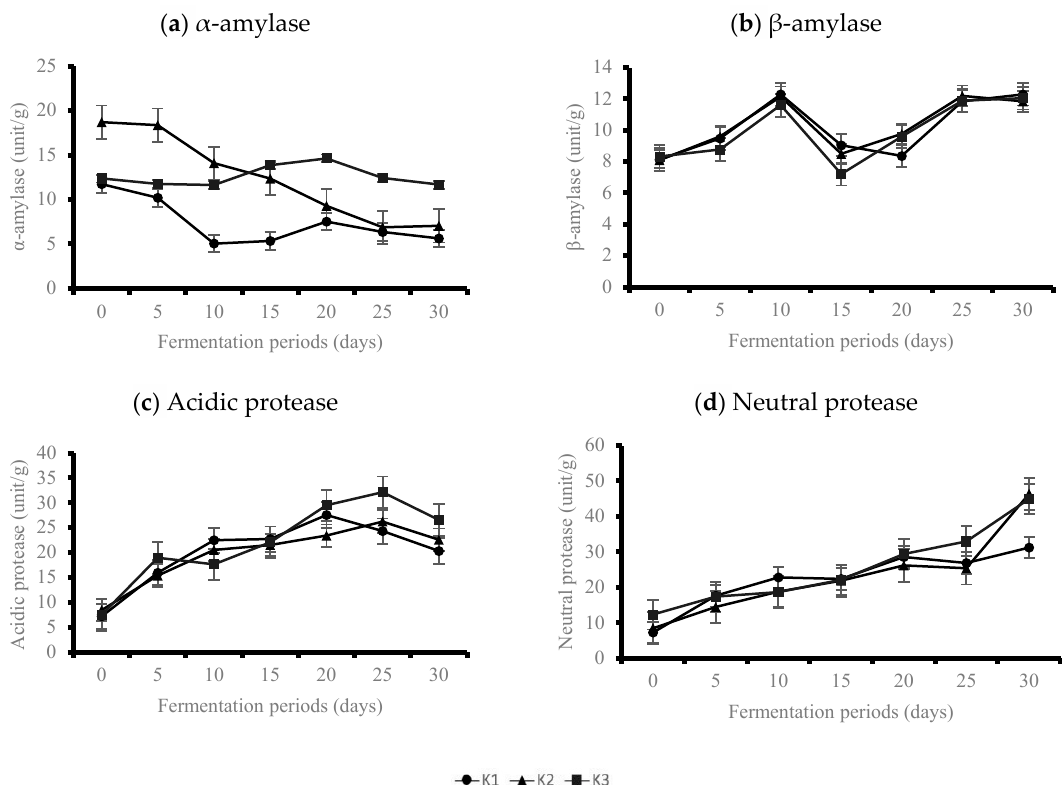
Figure 3. Changes of color of doenjang during 30 days of fermentation period. ( a ) L* value ( b ) a* value ( c ) b* value.